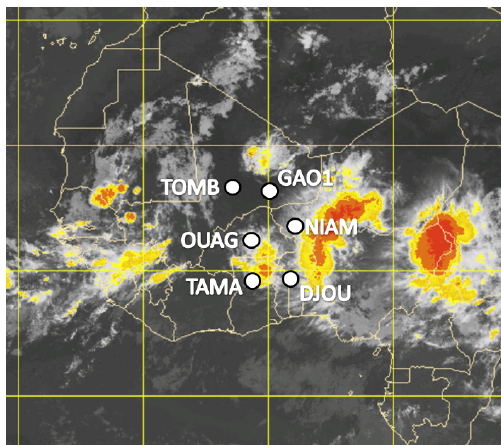
Figure 1. Meteosat-8 infrared image of West Africa on 10 Au- gust 2006 at 23:00UTC. Brightness temperatures range between 225K (yellow) and 195K (red). The position of the six AMMA GPS stations are shown as white dots: TOMB (Timbuktu, Mali), GAO1 (Gao, Mali), OUAG (Ouagadougou, Burkina Faso), NIAM (Niamey, Niger), TAMA (Tamale, Ghana), and DJOU (Djougou, Benin). Meteosat-8 infrared background: © 2019